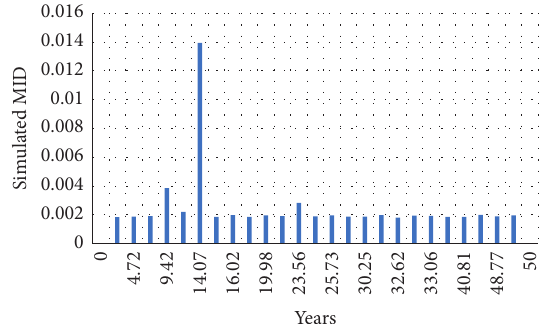
Figure 14: Simulated maximum inter-story drift.